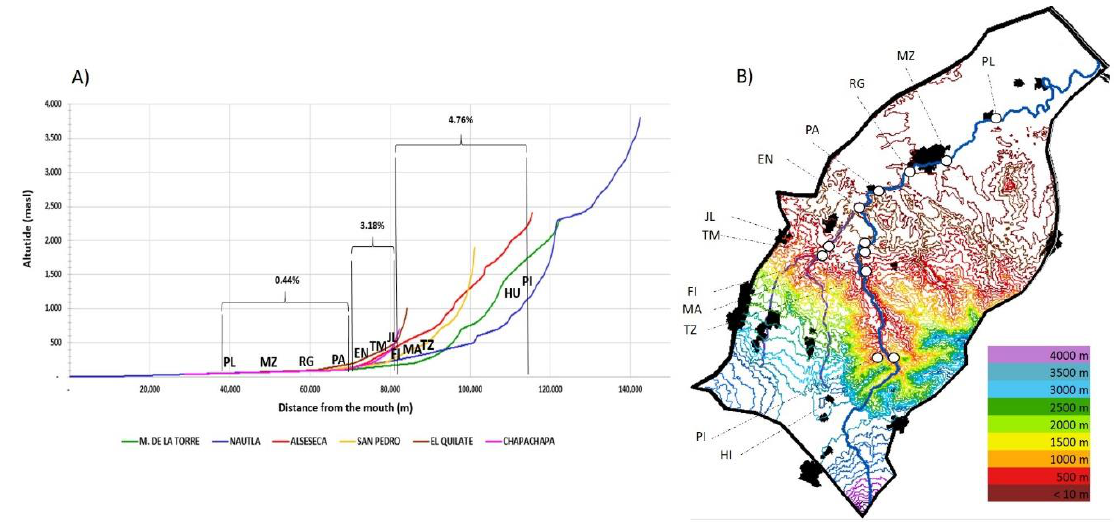
Figure 3. Altitudinal profile and topographic relief of the Bobos-Nautla River. ( A ) Altitudinal profile of streams in the Bobos-Nautla River basin. The relative slope (%) for each section is shown in brackets according to the clustering from the dissimilarity analysis. ( B ) Topographic relief of the Bobos-Nautla River watershed.